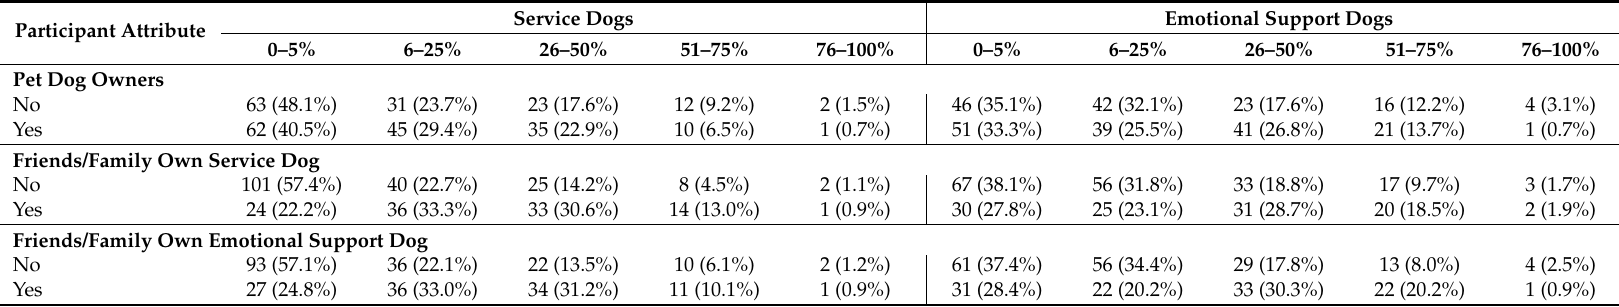
Table 7. Relationship of participants’ exposure to assistance animals and pet ownership with perceived prevalence of service animal misrepresentation, as assessed by the question “what percentage of people with a service dog/emotional support animal do you feel are just taking advantage of the